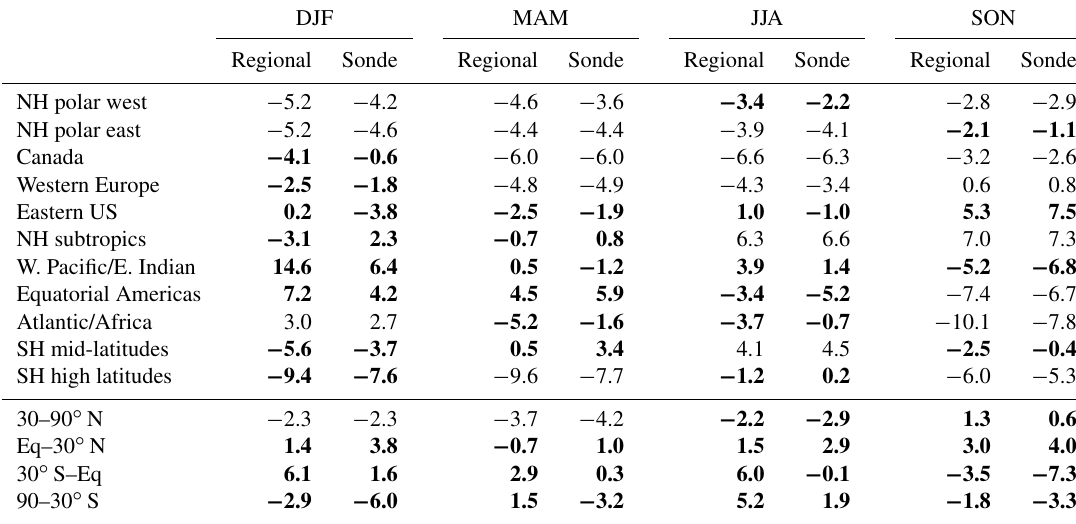
Table 9. The control run minus reanalysis comparison of the mean ozone concentration at 500hPa (in % relative to the reanalysis concentra- tions). Results are the regional averages (Regional) and at the ozonesonde temporal–spatial sampling (Sonde). Relative differences between the two estimates larger than 30% are shown in bold.